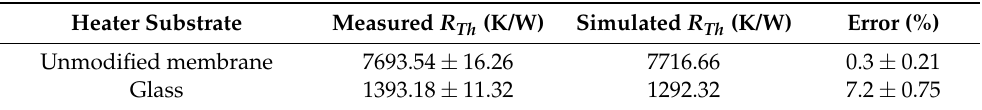
Table 1. Comparison of absolute values of R Th obtained by measurements ( n = 5 for membrane and n = 4 for glass) and 3D FEM simulation.